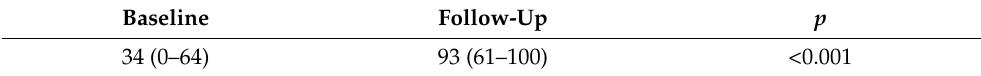
Table 2. Comparison of VISA-A baseline measure and follow-up comparison (mean (range)).